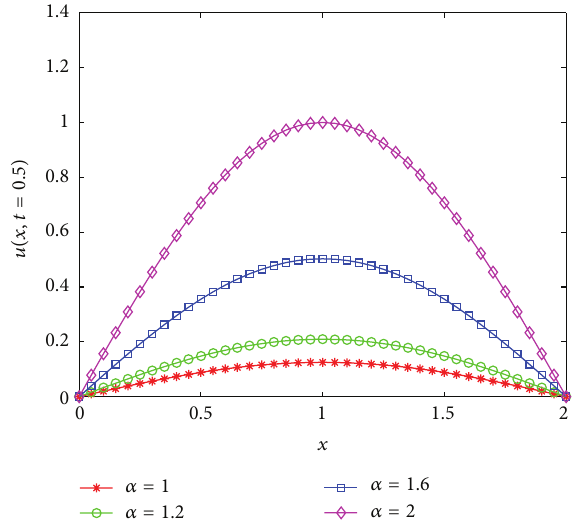
Figure 4: Dependence of the numerical solution for different values of 𝛼 byNumericalAlgorithmII(see(61))with 𝜏 = 0.002, ℎ = 0.0025 .